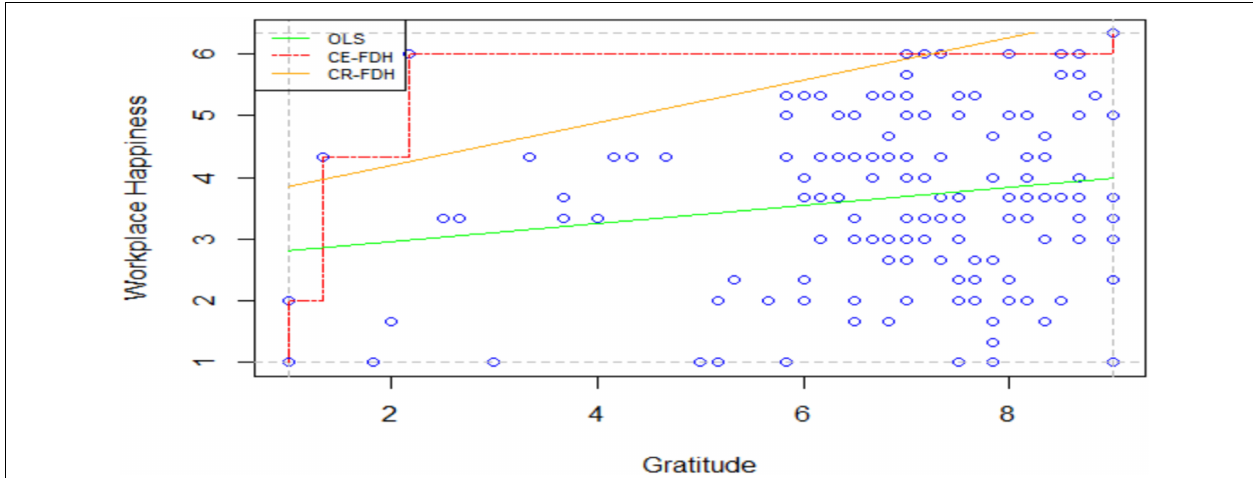
FIGURE 1 | NCA plot (gratitude and workplace happiness). Primary data.